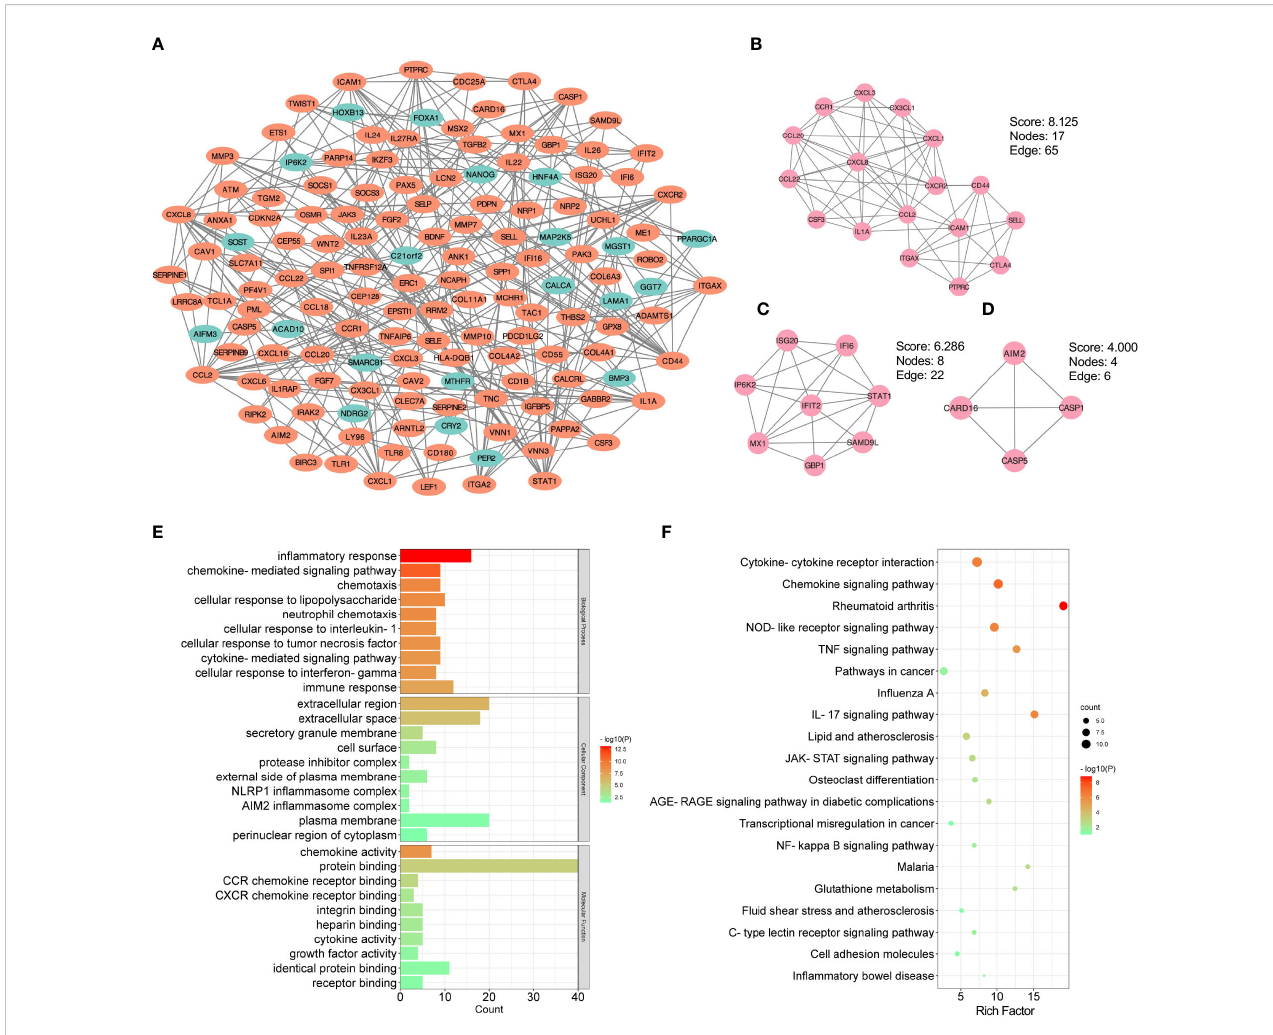
FIGURE 4 PPI and modular analysis of common DEGs. (A) The PPI network of common DEGs. Orange indicates up-regulated genes, and blue-green indicates down-regulated genes. (B-D) Top three gene clustering modules in MCODE analysis. (E, F) GO and KEGG enrichment analysis of total modular genes. PPI, protein-protein interaction; DEG, differentially expressed genes; GO, Gene Ontology; KEGG, Kyoto Encyclopedia of Genes and